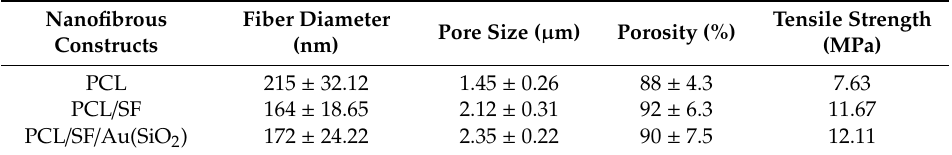
Figure 1. FESEM images of the electrospun ( a ) PCL, ( b ) PCL / SF, ( c ) PCL / SF / Au(SiO 2 ) nanofibrous sca ff olds. ( d , e ) TEM images of PCL / SF / Au(SiO 2 ) nanofibrous sca ff olds. Table 1. Characterization of nanofibrous sca ff